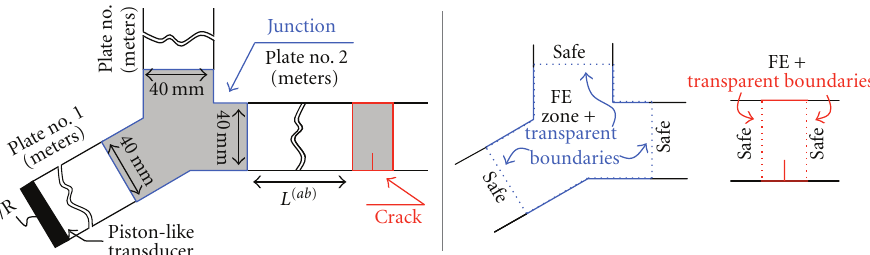
Figure 13: Left: configuration of testing of plate number 2 through a triple junction. Right: the two phenomena of scattering (junction, crack) are computed independently by FE; guided propagations are computed by SAFE.